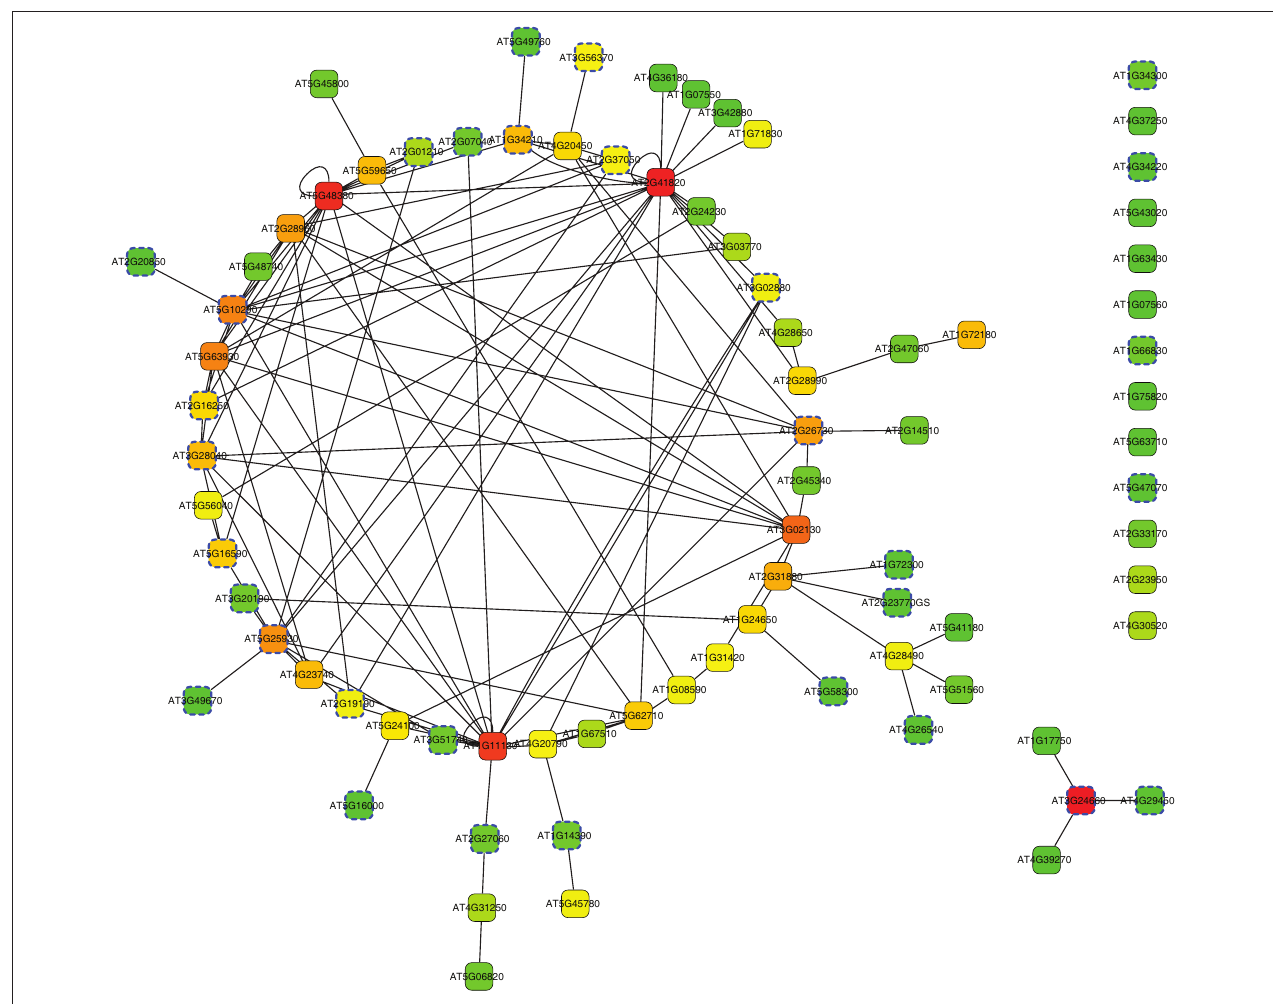
Figure 5 | Sub-network of receptor kinase interactions (rLK). Labeling as in Figure 3 . The blue borders surrounding 31 individual RLKs indicate evidence for phosphorylated sites according to PhosPhAt 3.0 (Durek et al.,